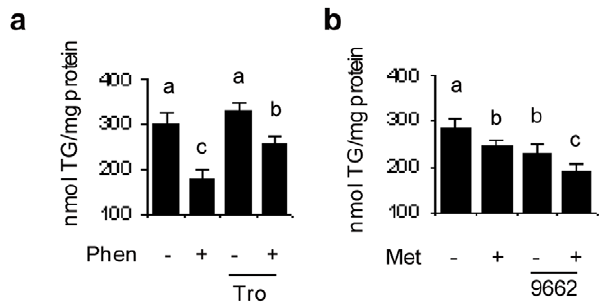
Figure 5. PPAR c agonists or antagonists affect the TG loss caused by AMPK activators without t 10 c 12 CLA being present. a Differentiated 3T3-L1 adipocytes were incubated with or without 0.1 mmol/L phenformin (Phen), with or without PPAR c agonist troglitazone (Tro), and TG levels were measured after 24 h. b TG levels were measured in differentiated 3T3-L1 adipocytes in media lacking or containing 2 mmol/L metformin (Met), with or without PPAR c antagonist GW9662 (9662) for 24 h. Each bar represents the mean + SEM (n=3), and is representative of three independent experiments. Means not sharing a common letter differ, P ƒ 0.05. doi:10.1371/journal.pone.0048874.g005 tions of malonyl-CoA should reduce the rate of fatty acid biosynthesis and increase the rate of fatty acid oxidation, as attenuated levels of malonyl-CoA no longer inhibit carnitine